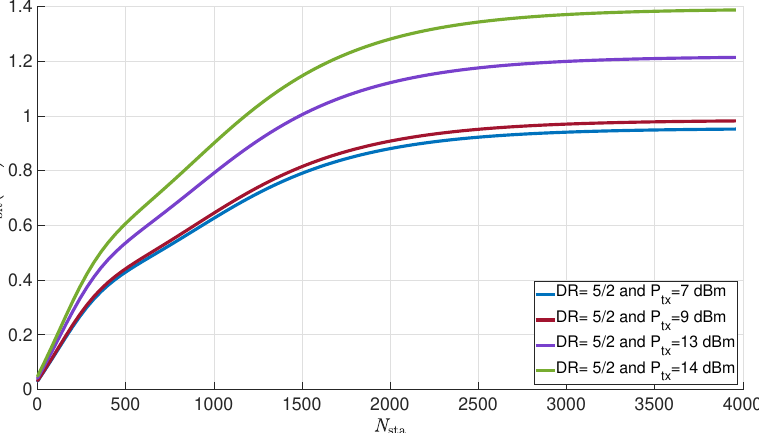
Figure 17. Average energy consumed per useful bit by a LoRa sensor for various transmit powers vs. number of nodes in the network (FPayload = 50 bytes; NR = 8; d = 1 km; dc =